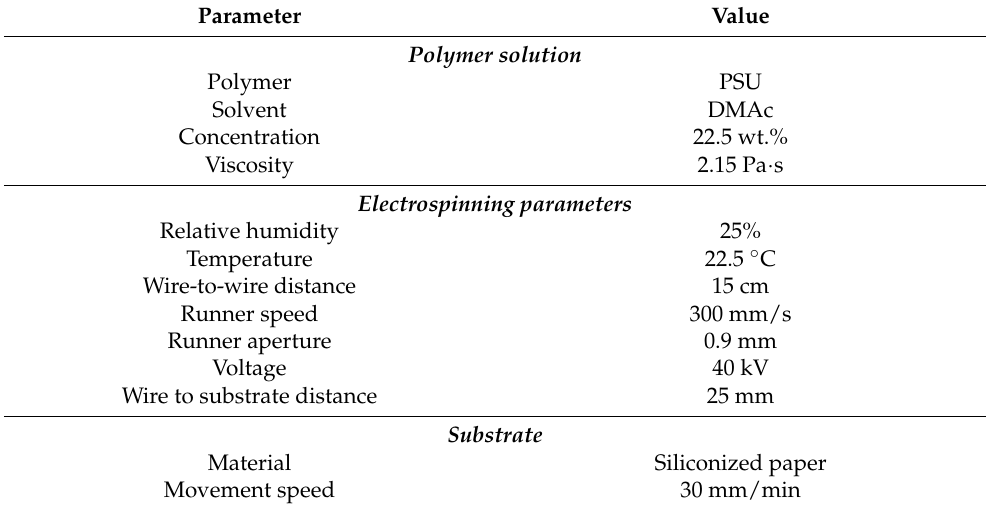
Table 1. Electrospinning